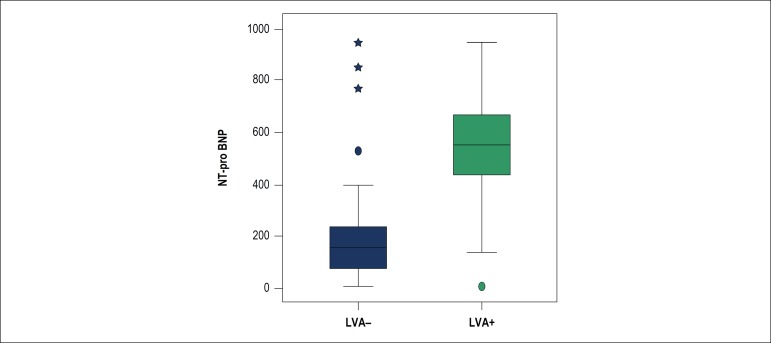
Patients who developed left ventricular aneurysm after acute ST-elevation myocardial infarction had higher NT-pro BNP levels at admission. NT-pro BNP: N terminal pro-B-type natriuretic peptide LVA: left ventricular aneurysm.